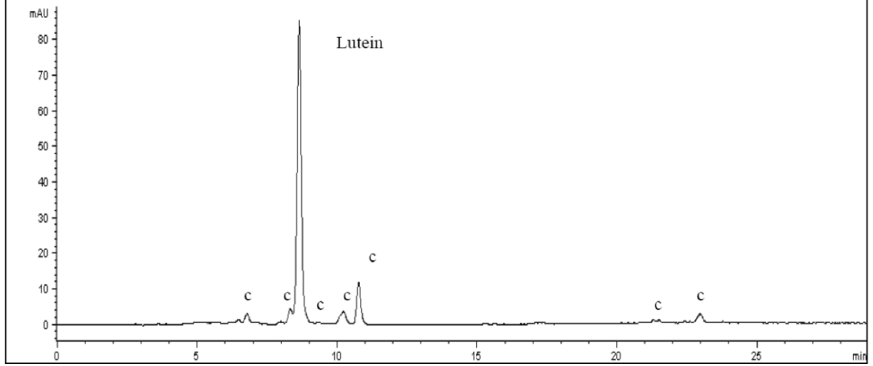
Figure 2. Chromatographic profile (Relative abundance as y axis vs Retention time as x axis) at 450 nm of a carotenoid acetone fraction of egg cooked pasta extract. Identified compounds: Lutein, c = carotenoid derivatives.